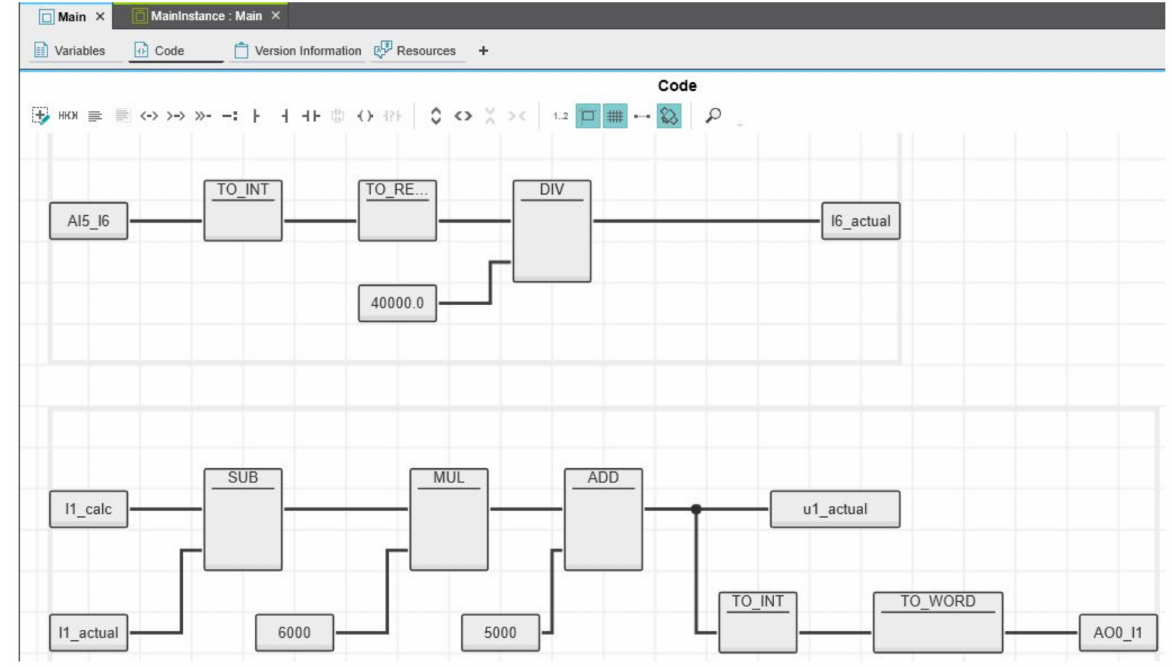
Figure 14. Part of the code of the Stewart platform